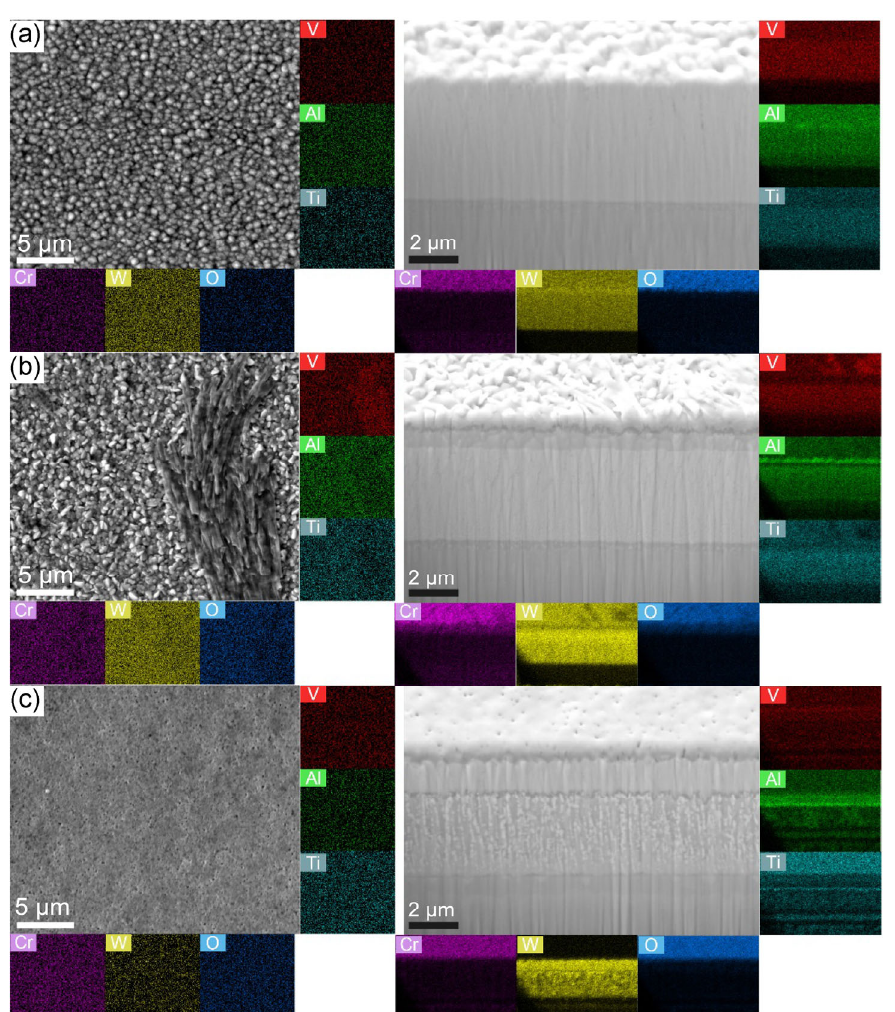
Fig. 4 SEM micrographs of surface and cross-sectional morphologies and EDS mapping images of the films after oxidation of 700 °C (a), 800 °C (b), and 900 °C